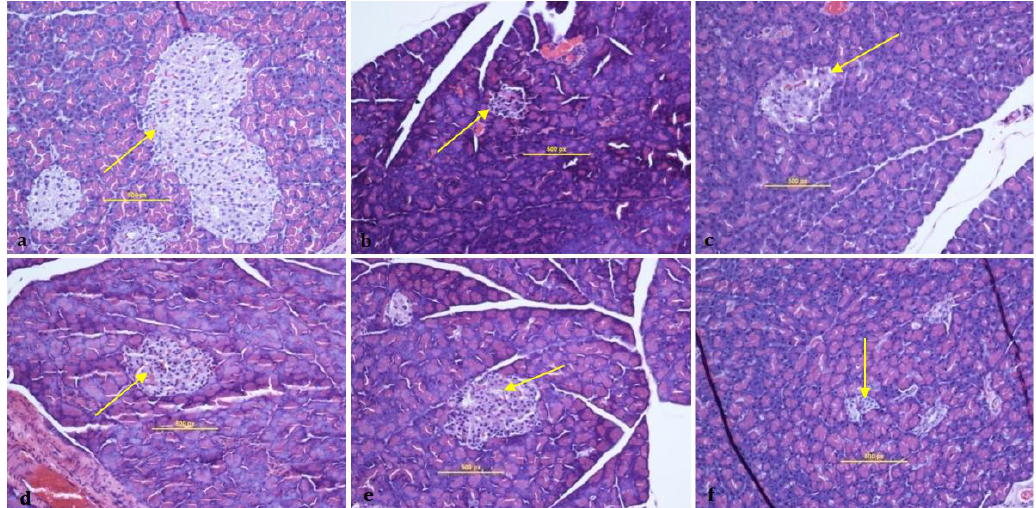
Figure 4. Histopathological changes in the pancreas of normal and experimental rats. All the sections are in H&E 40X. (a) Control rat pancreas. Normal pancreas with islet cell surrounded by acini (yellow arrow). (b) Diabetic rat pancreas shows atrophic acini with fatty infiltration (yellow arrow). (c) Diabetic + 100 mg/kg of MPMTE (mild expansion and absence of dilations) (yellow arrow). (d) Diabetic + 200 mg/kg of MPMTE (moderate expansion of pancreatic islets) (yellow arrow). (e) Diabetic + 400 mg/kg of MPMTE (moderate expansion of islet cells with few atrophic acini) (yellow arrow). (f) Diabetic + 100 mg/kg of Metformin (atrophic acini with fatty infiltration (yellow arrow).